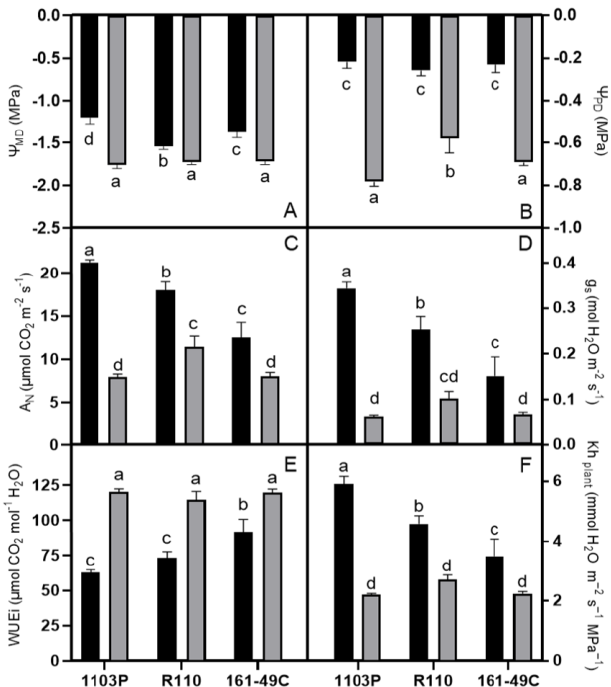
Figure 1. Effect of rootstocks and water stress (WS) on plant gas exchange and water status measure- ments. ( A ) Mid-day water potential ( Ψ MD ), ( B ) pre-dawn water potential ( Ψ PD ), ( C ) net photosyn- thesis (A N ), ( D ) stomatal conductance (g s ), ( E ) intrinsic water use efficiency efficiency (WUE i ) and ( F ) whole plant hydraulic conductivity (Kh plant ). Black and grey bars represent well water (WW) and WS treatments, respectively. Values represented are means ± standard error of each treatment and rootstock. Different letters denote statistically significant differences by one-way ANOVA with Duncan’s multiple comparison test ( p < 0.05).